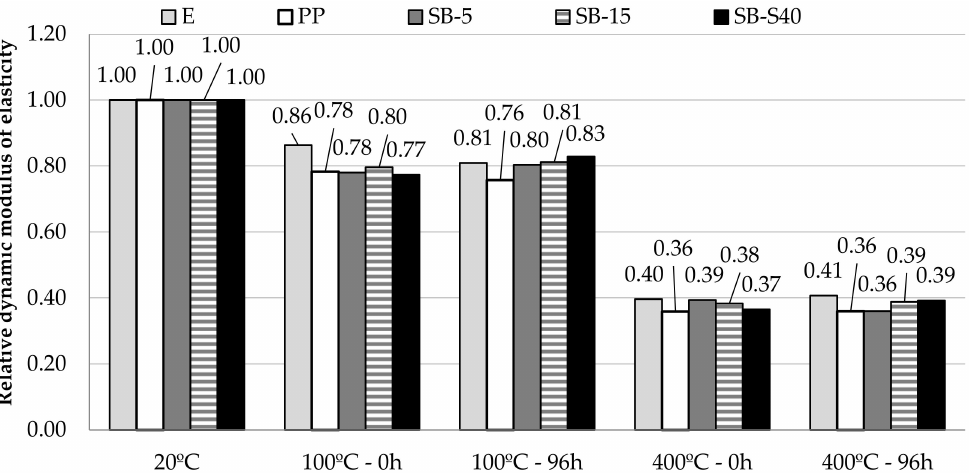
Figure 6. Residual dynamic modulus of elasticity of specimens compared with the dynamic modulus of elasticity of the same mixture at room temperature.